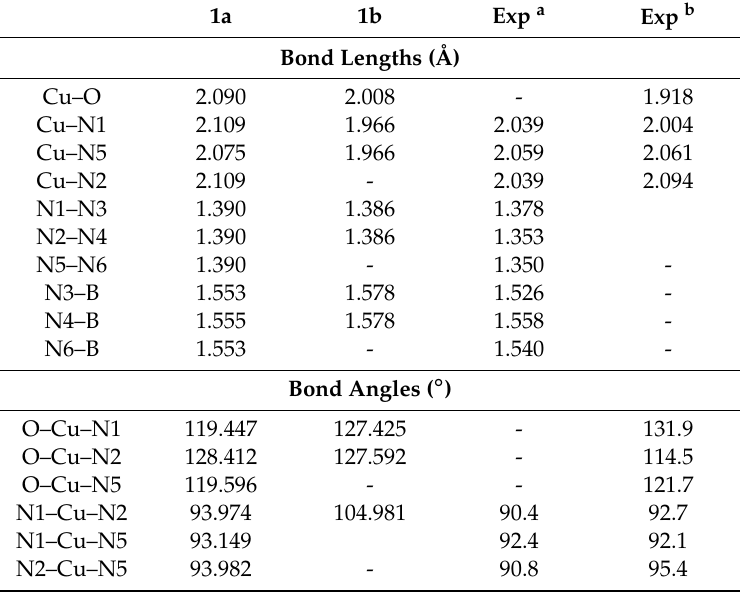
Table 1. Selected theoretical parameters of the geometry of 1a and 1b and their comparison with the experimental parameters [20,21].